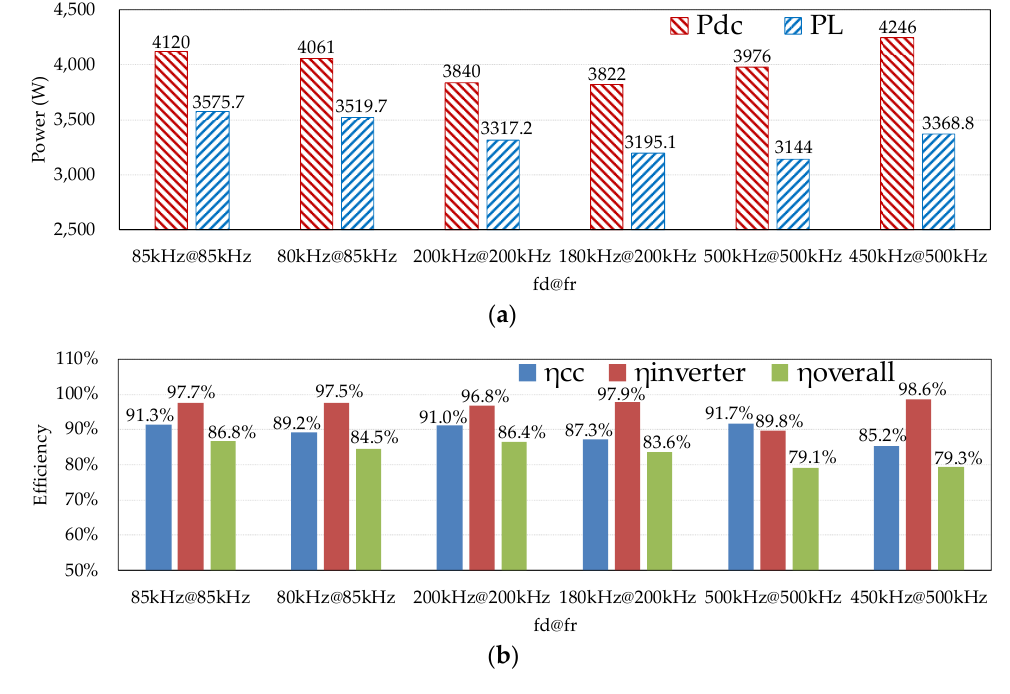
Figure 12. Experimental performance of the three systems: ( a ) power; ( b ) efficiency.